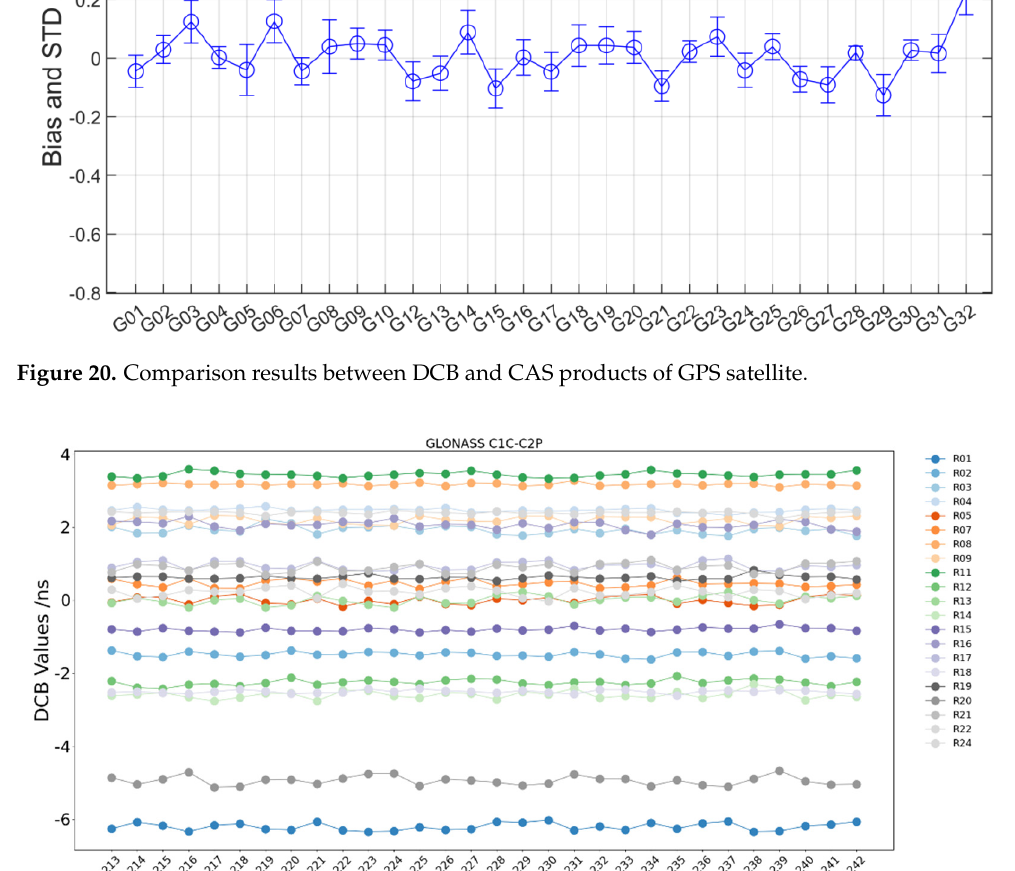
Figure 21. C1C–C2P DCB time series of GLONASS satellites.